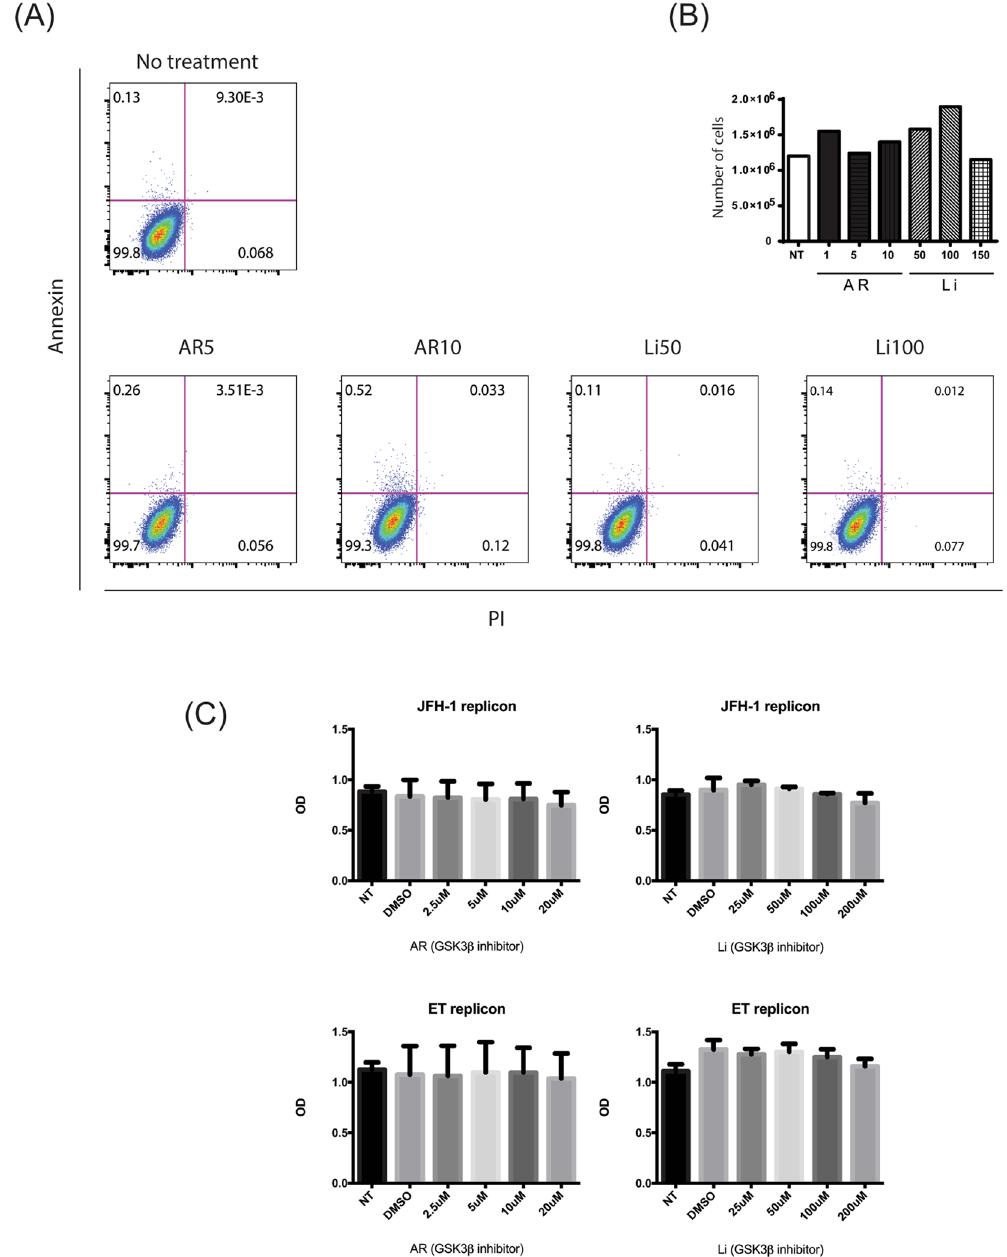
Figure 4. GSK3 β inhibitors have no effect on cell apoptosis and cell death. ( A ) 10,000 cells were stained with annexin V and propidium iodide, and examined by flow cytometry. ( B ) No change in cell viability was also shown using trypan blue viability stain in treated and non-treated cells. ( C ) In parallel, cell proliferation and viability was demonstrated by the MTT proliferation assay on the used replicon cells. (n = 2 Independent